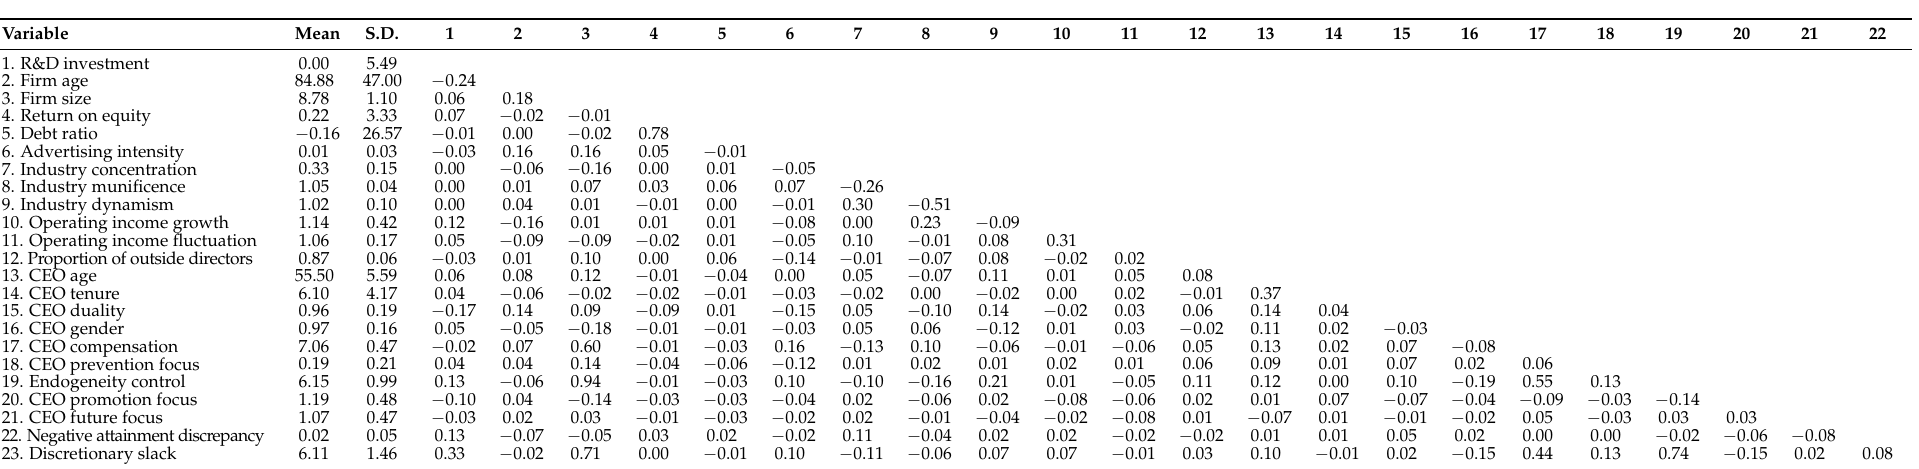
Table 1. Descriptive statistics: Means, standard deviations, and